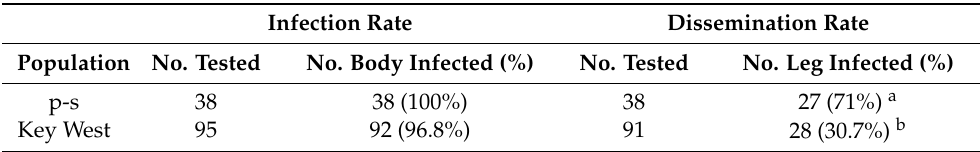
Table 5. Infection rate and dissemination rate of the Ae. aegypti populations after 14 days of DENV-1 infection. Infection Rate Dissemination Rate Population No. Tested No. Body Infected (%) p-s Key West 95 92 (96.8%) 91 28 (30.7%)